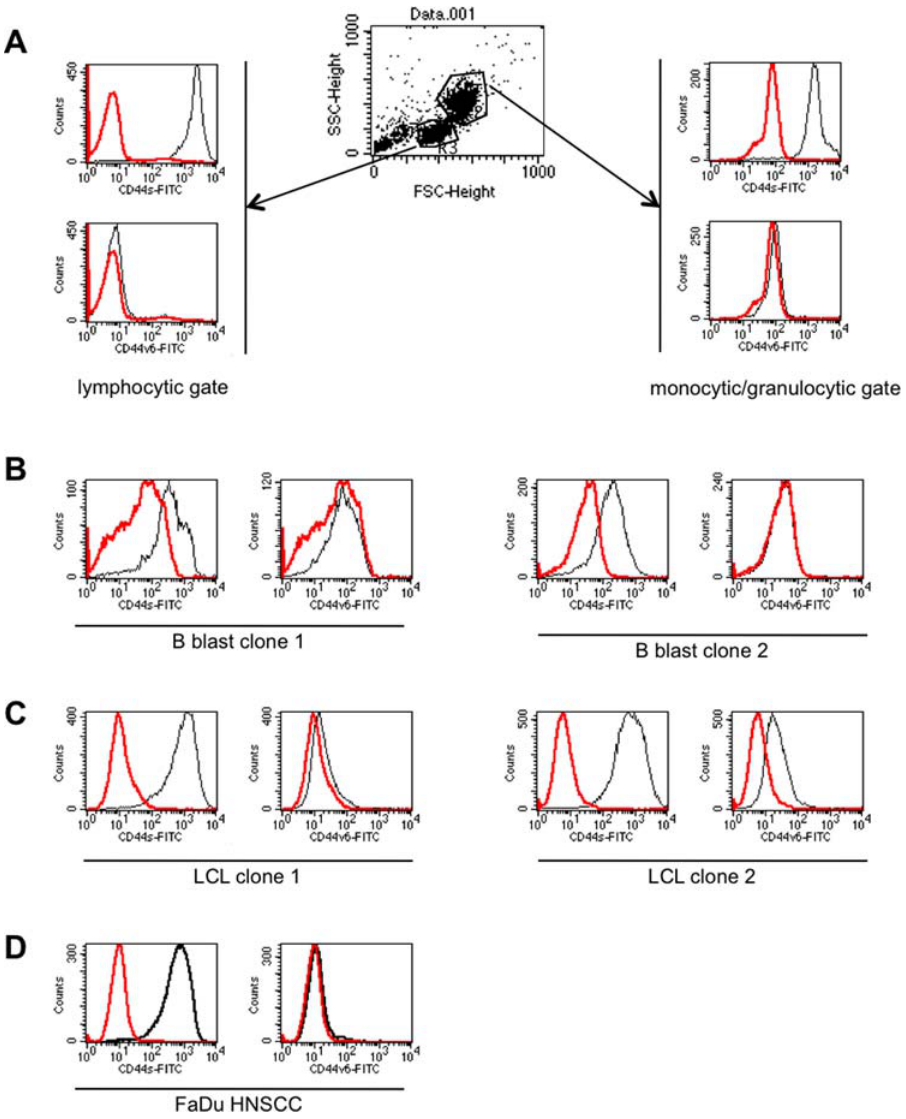
Figure 5. Comparative expression of CD44s and CD44v6 in lymphoid cells. Cell surface expression of CD44s and CD44v6 were assessed on peripheral blood mononuclear cells ( A ), B blast clones ( B ), lymphoblastoid cell clones ( C ), and HNSCC FaDu cells ( D ) using specific antibodies and flow cytometry. Red line: control; black line: specific antibody. LCL: lymphoblastoid cell lines. Shown are representative results of two independent